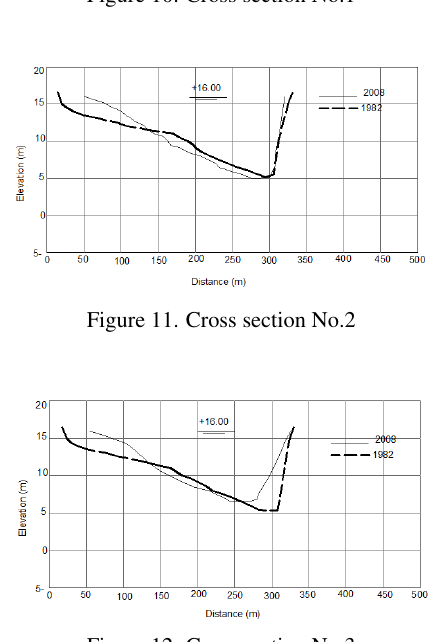
Figure 10. Cross section No.1